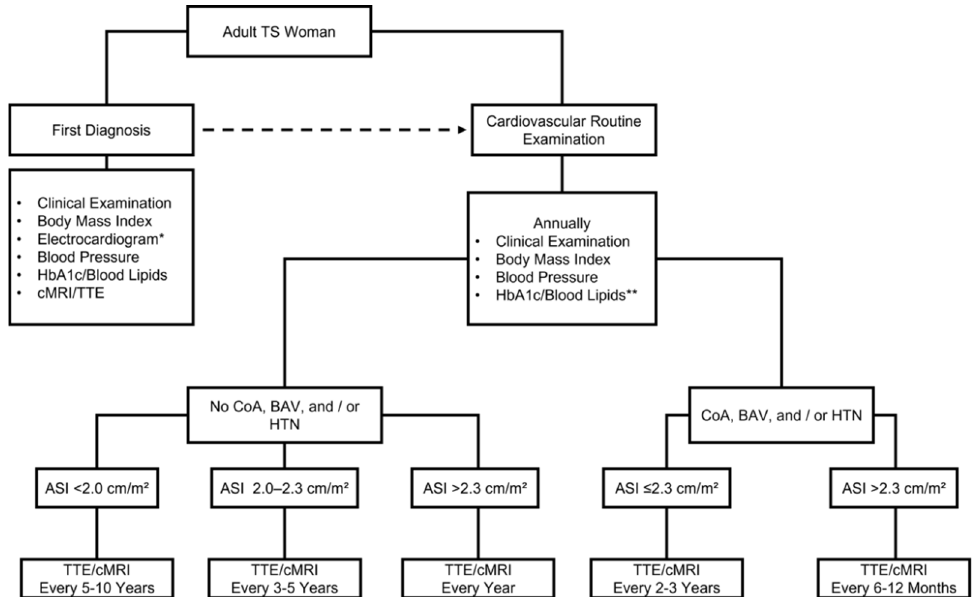
Figure 1. Cardiovascular care of adult women with Turner Syndrome. Modified after the 2016 Clinical Practice Guidelines for the Care of Girls and Women with Turner Syndrome [2]. cMRI, cardiac magnetic resonance imaging. TTE, transthoracic echocardiography. CoA, coarctation of the aorta. BAV, bicuspid aortic valve. HTN, arterial hypertension. ASI, aortic size index. * Hodges formula should be preferred for QTc measurement. If QTc >460 ms, 24 h Holter-monitoring and exercise testing should be performed for risk stratification. ** Annually if recommended regionally or at least one cardiovascular risk factor is present (arterial hypertension, excess weight, smoking, physical inactivity).